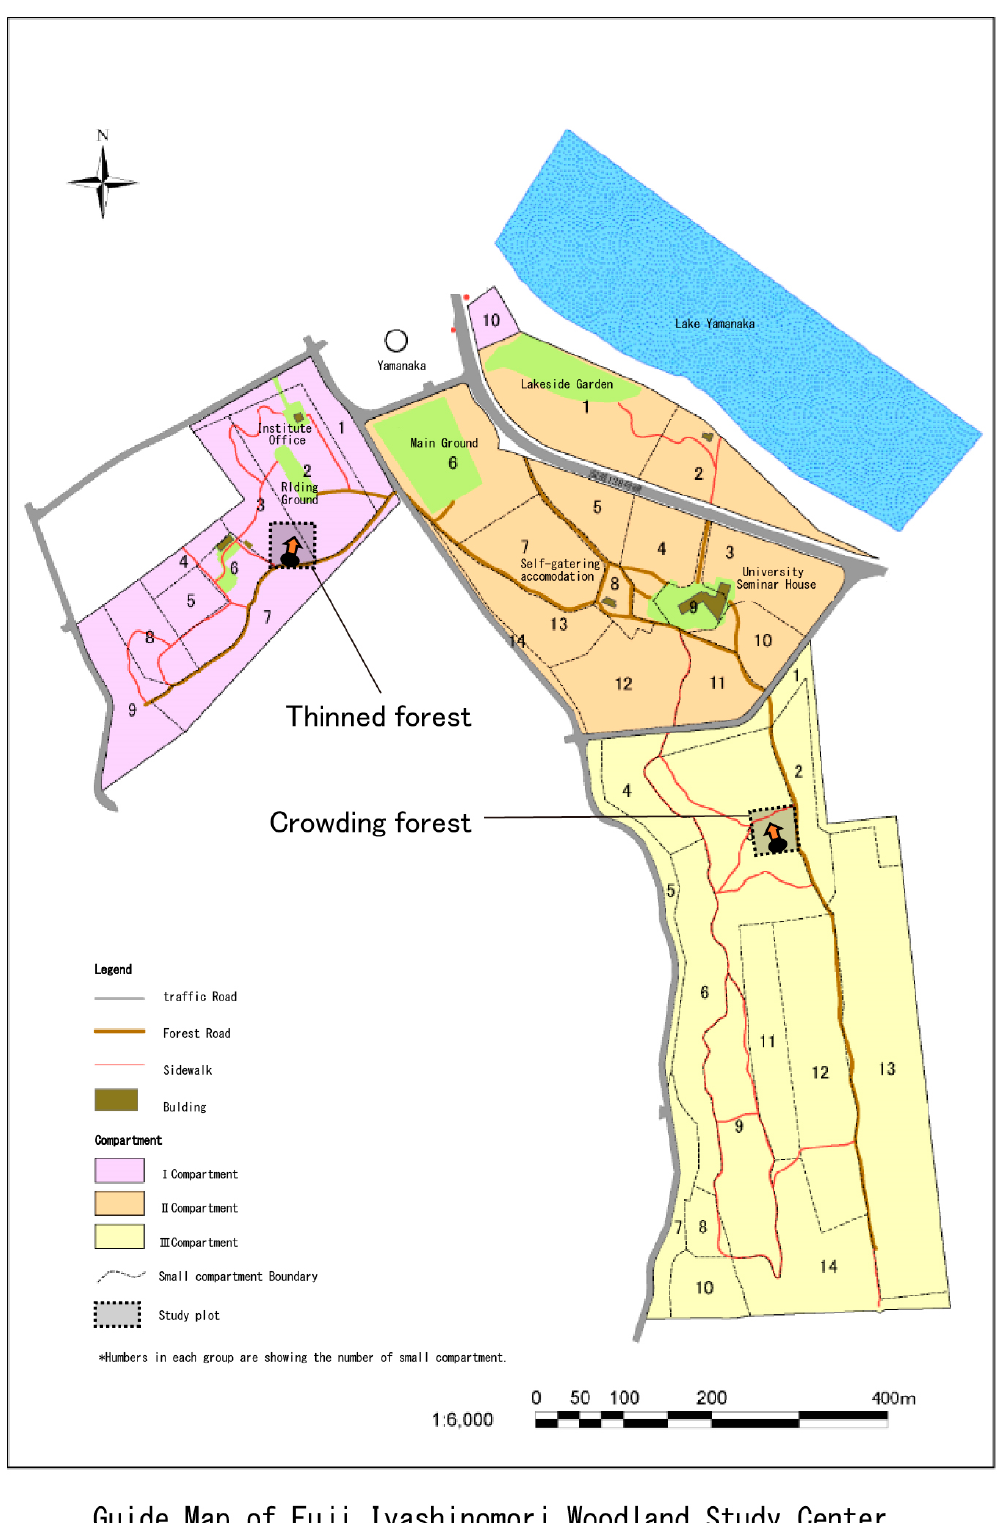
Figure 3. The experimental plots. The authors modified this figure from the figure on the Fuji Iyashinomori Woodland Study Center’s website (http://www.uf.a.u-tokyo.ac.jp/fuji).